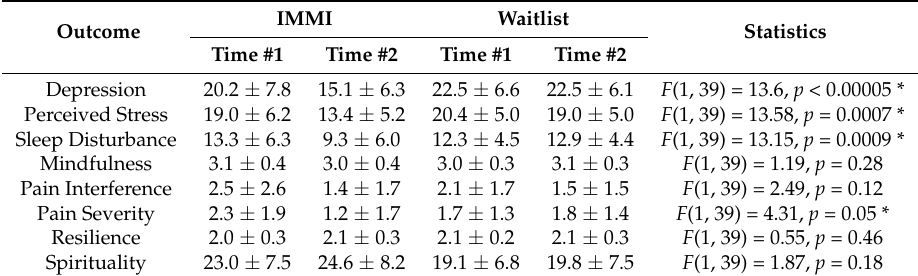
Table 2. Outcomes of IMMI and waitlist participants.